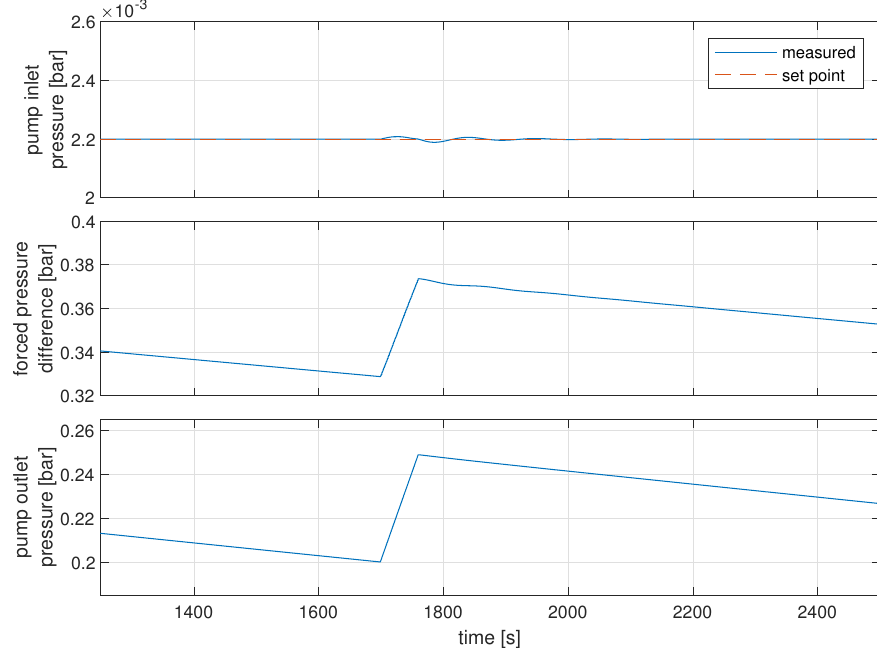
Figure 15. Pump inlet pressure (bar) ( top , blue solid line) and pump inlet pressure set point (bar) ( top , red dashed line); pressure difference generated by the pump (bar) ( middle ) with pump outlet pressure (bar). ( Bottom ) PID with feed-forward.